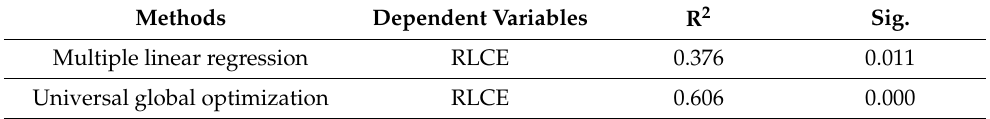
Table 6. Comparison of the results with Pearson correlation coefficient and Universal global